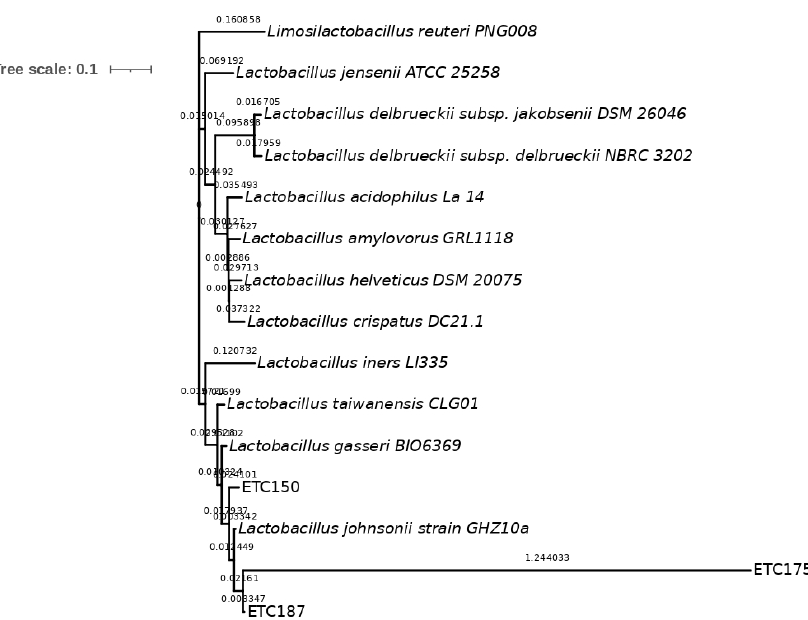
Figure 2. Maximum-likelihood tree with gyrB gene sequences. Bar, 10% nucleotide substitutions.